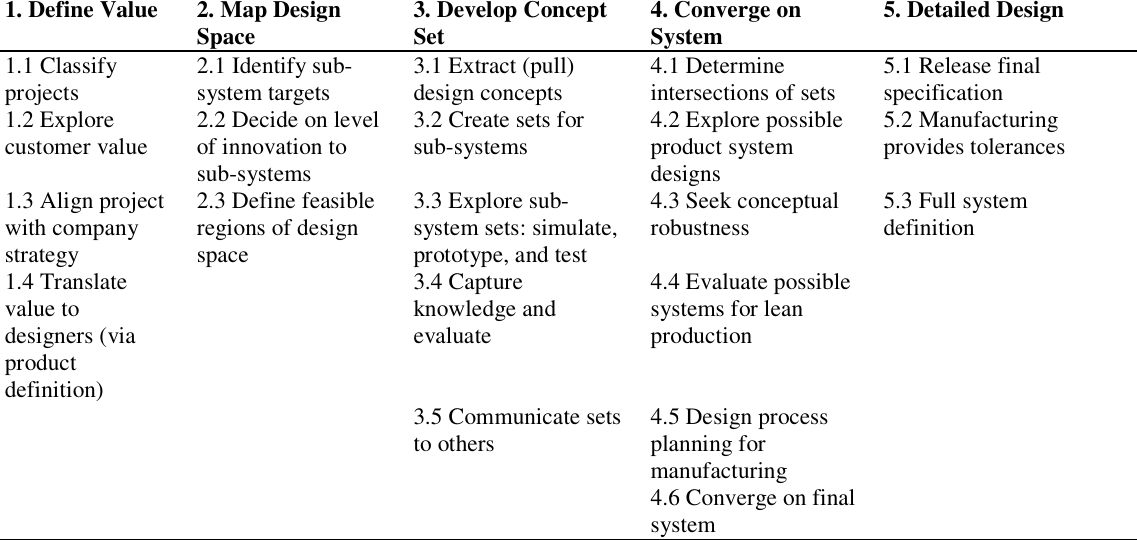
The fundamental CONGA SBD process